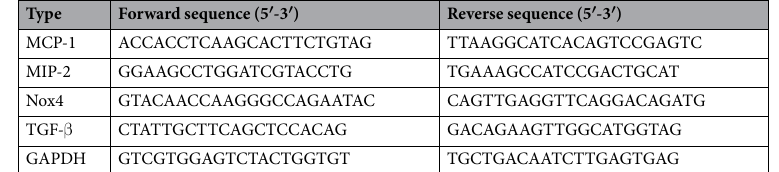
ATP measurement.